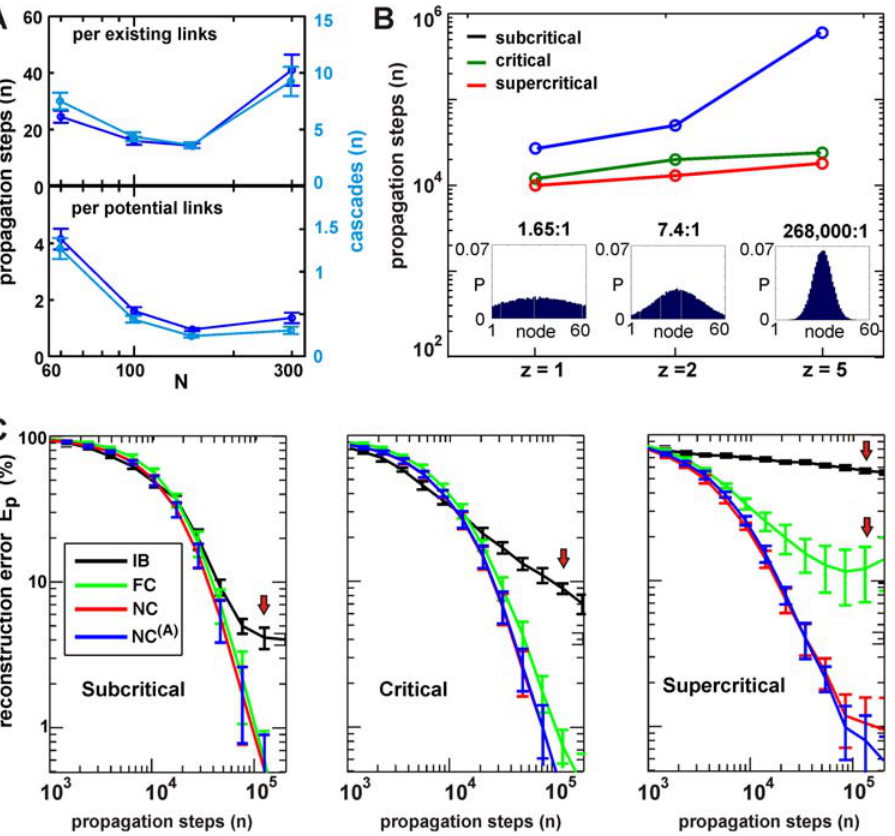
Figure 4. Robustness of the NC for heterogeneous network dynamics. (A) NC scales well with an increasing number of nodes N in terms of number of propagation steps, N p (dark blue) and cascades (light blue) needed to reconstruct network topology within 1% accuracy. The number of needed steps N p (cascades) is normalized by the number of existing links ( Nk d , top) and the total number of potential links ( N N { 1 ð Þ , bottom). (B) Network reconstruction in the face of large heterogeneities in node initiation distribution z ~ 1,2,5 . Performance measured in terms of number of propagation steps to reach 1% E p (ER network with N ~ 60; S k d T ~ 10, p d ~ 0 : 1 , 20% noise). Inset in B: Density plots of node initiation probability for z ~ 1,2,5 ). (C) Comparison of IB, FC and NC, when the actual activation probabilities p ij are heterogeneous (normally distributed with z ~ 5 ) and temporal jitter is introduced in the cascading dynamics (node activation has a 20% chance to be shifted to (t 2 1) or (t + 1)). Note that IB fails to reconstruct networks under these condition. FC is robust but only in the subcritical and critical regime. In contrast, NC and NC A ð Þ perform robustly for all regimes. Red arrows: reconstruction failure.